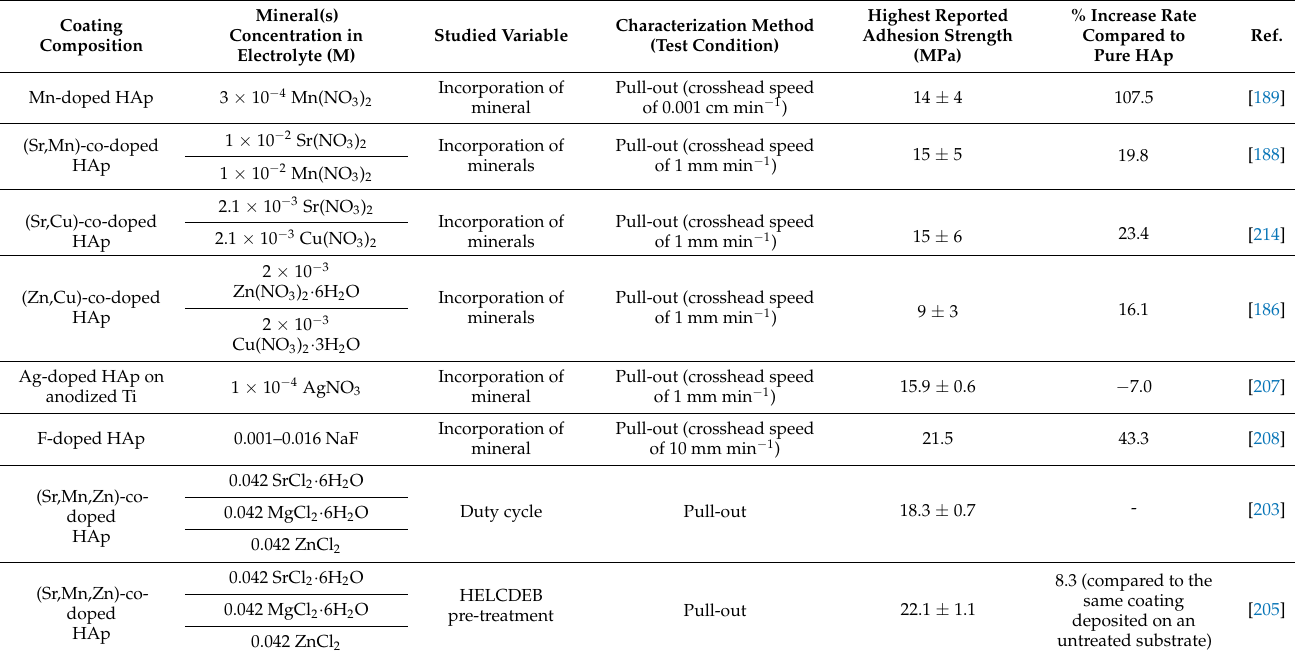
Table 9. The reported mechanical properties of mineral-substituted HAp coatings as a function of type, concentration of doped minerals and operational